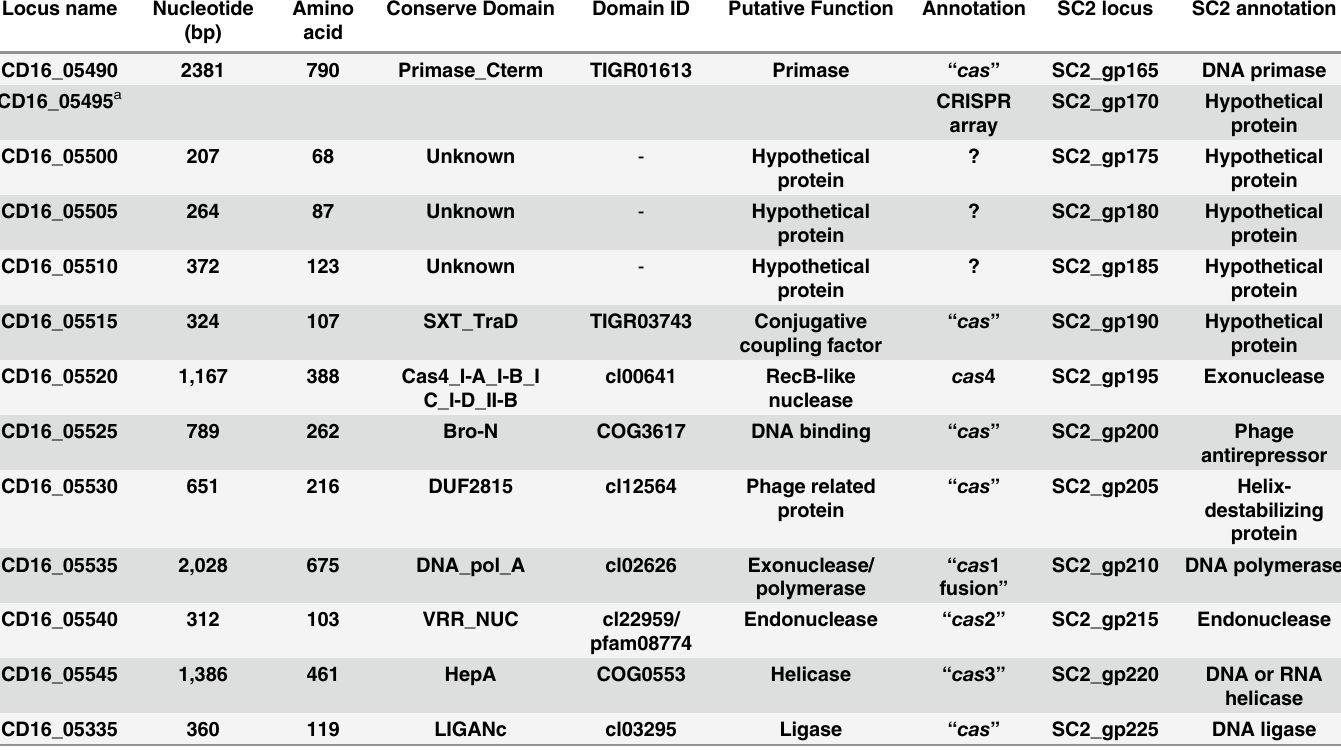
Table 3. Basic information of a predicted CRISPR/ cas system in prophage CGdP2 of “ Candidatus Liberibacter asiaticus ” strain A4 with compari- son to prophage SC2. Locus name